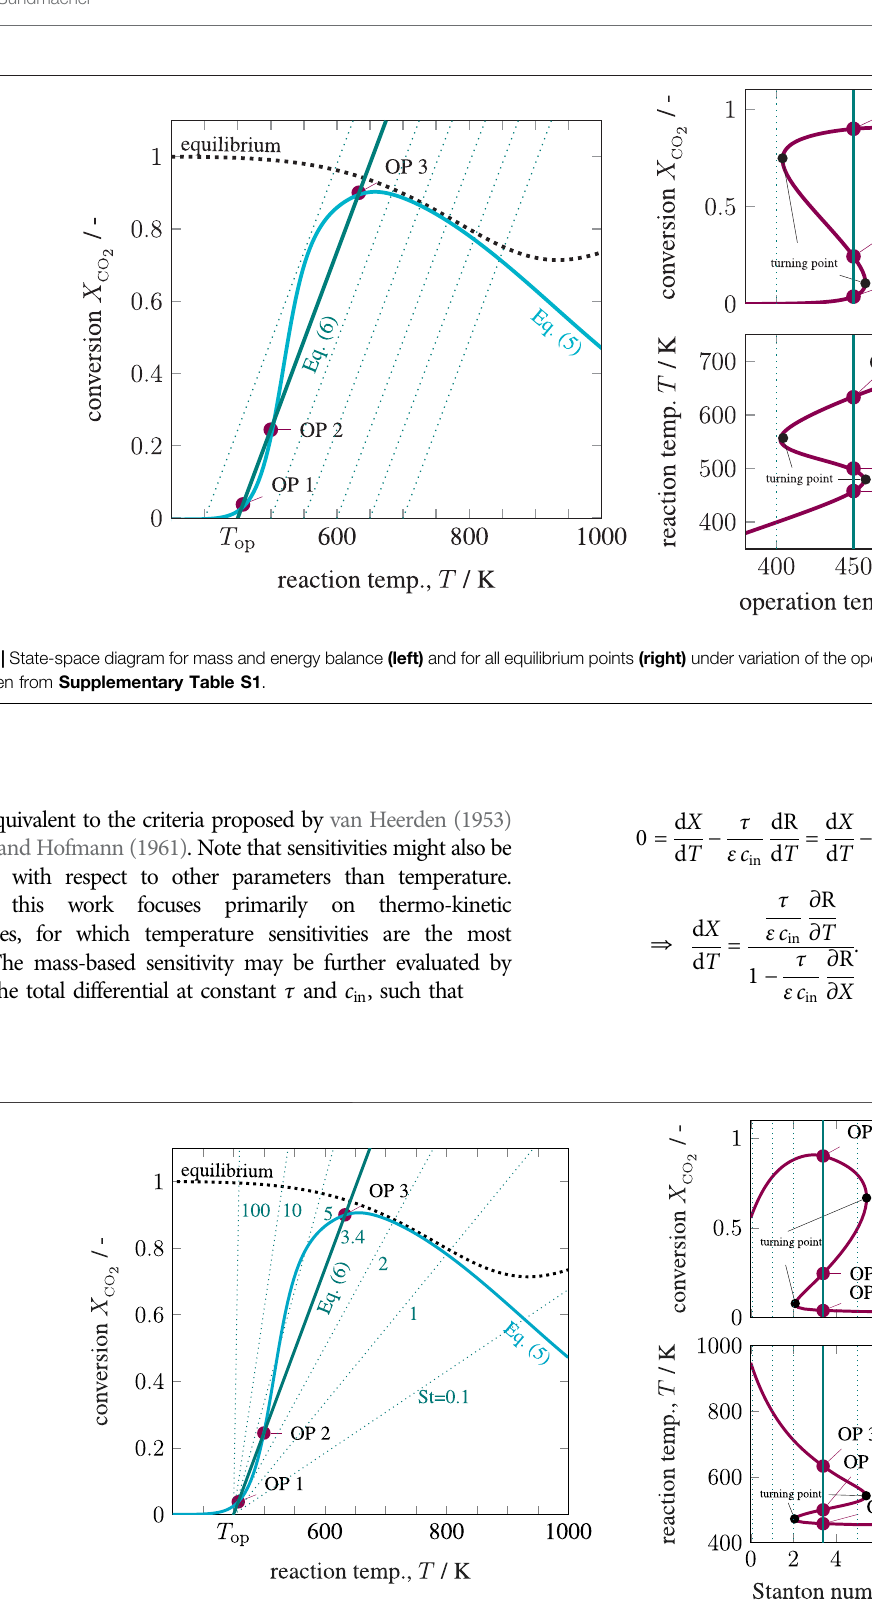
Frontiers in Energy Research |